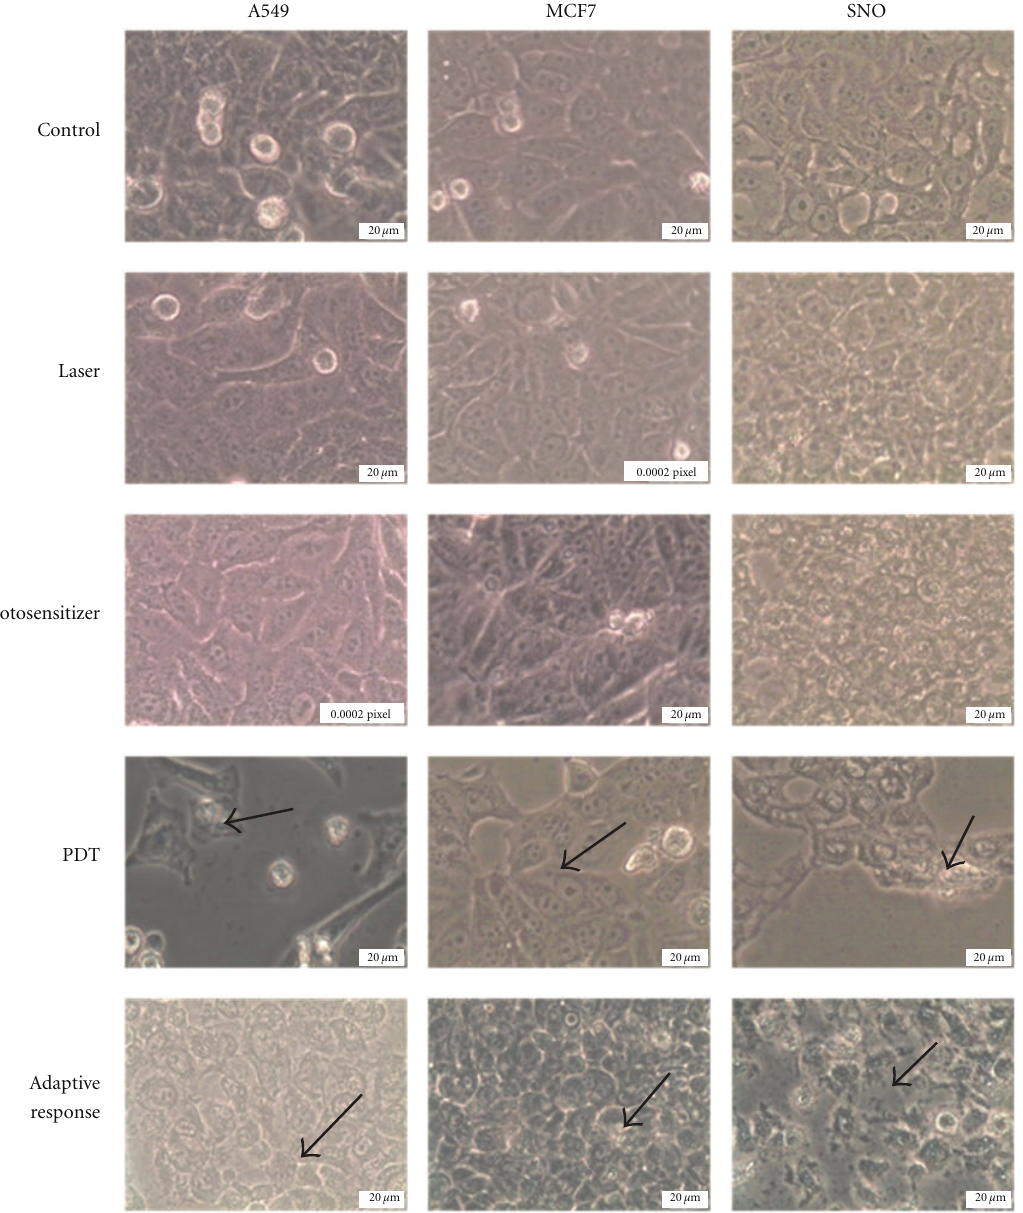
Figure 1: Human lung cancer cells (A549), Human breast cancer cell (MCF7) and Human esophageal cancer cells (SNO) under light micro- scope with 40X magnification showing a dramatic reduction of the cell viability in PDT groups and a less dramatic e ff ect on cell viability in cells pre-sensitized. This is also visible when studying the morphology of the cells where PDT treated cells show cells rounding and releasing from the flask indicative of cell